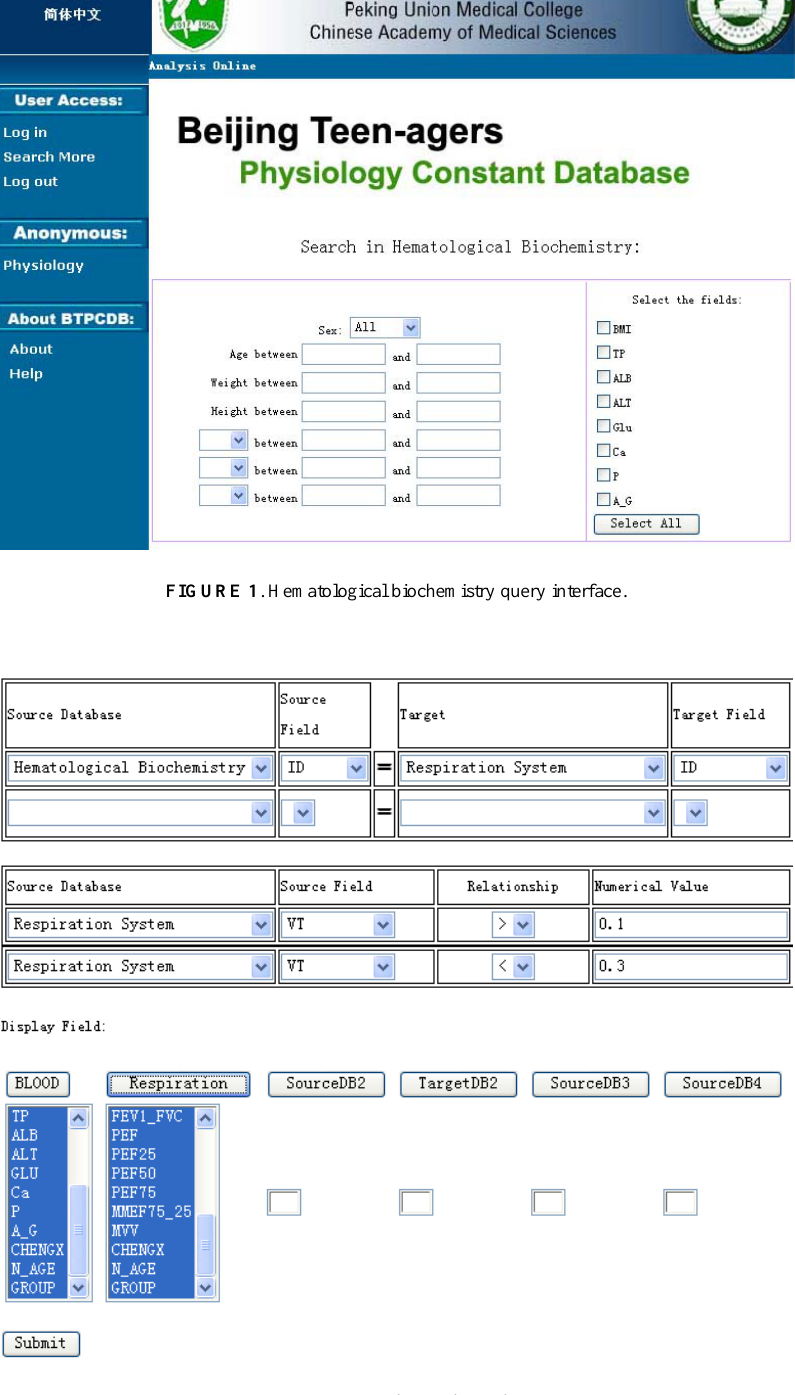
FIGURE 2 . Advanced